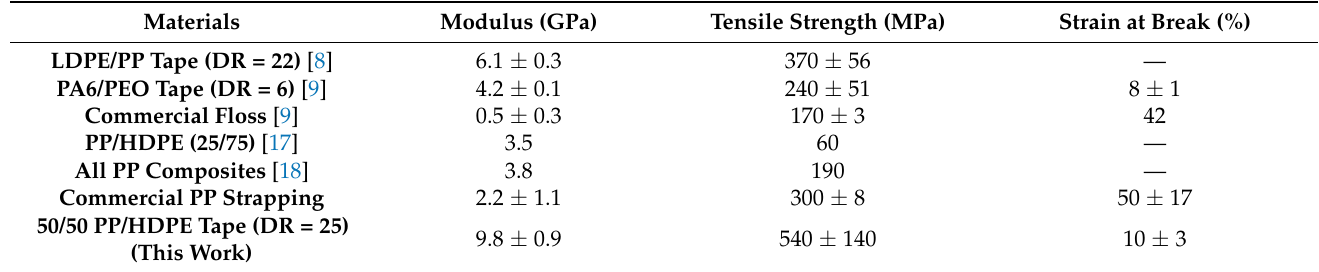
Table 3. Comparisons to Other Materials.